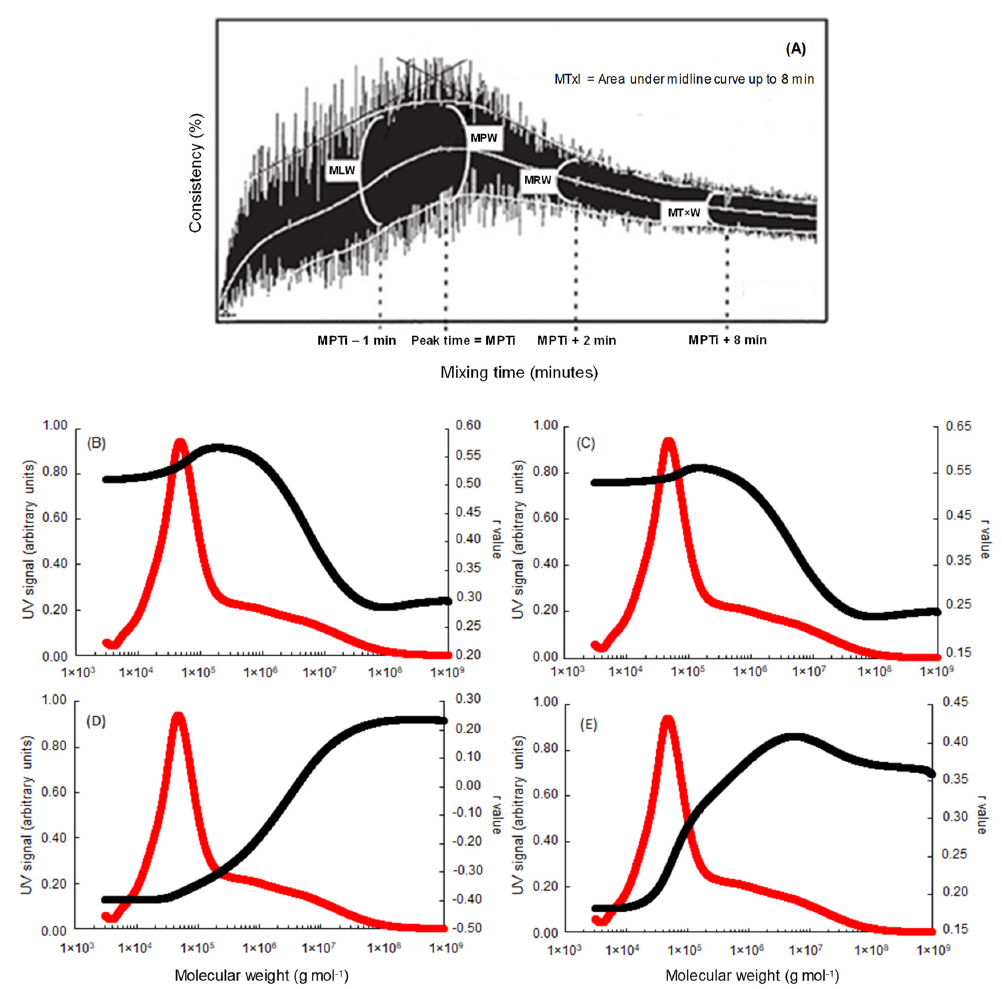
Figure 2. Representation of the different mixogram parameters used ( A ) and plot of simple linear correlation coefficients ( n = 780) between A4F data (weight-average molecular mass, Mw) and mixogram parameters: MPW ( B ), MLW ( C ), MT × I ( D ), and MT × W ( E ). The UV signal (214 nm), which is represented by the red line, corresponds to the mean fractogram of the 130 wheat genotypes studied. Table 1. Abbreviations, averages, and ranges of the five Mixogram parameters and the four Alveogram parameters used for the characterization of the 130 cultivars grown in six locations (780 samples).